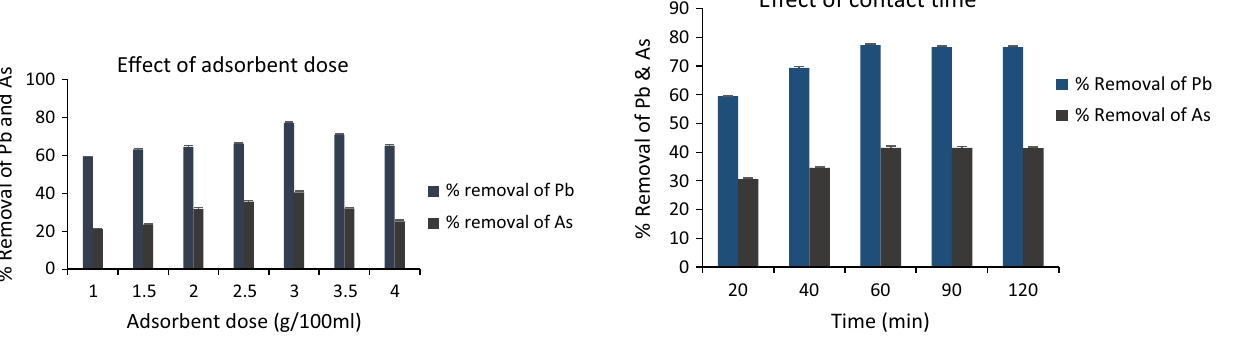
Fig. 7 Effect of adsorbent dose on adsorption of Pb and As. Experi- mental conditions: pH 4.0 (Pb) and 2.0 (As), temperature 37 °C and contact time 24 min. Values are mean ± SE, n = 3